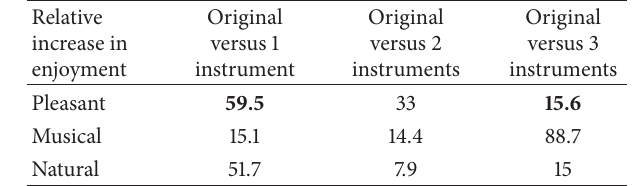
Table 2: Relative increase of enjoyment of the original music sample compared to modified versions containing 1–3 instruments among NH listeners with CI simulation.